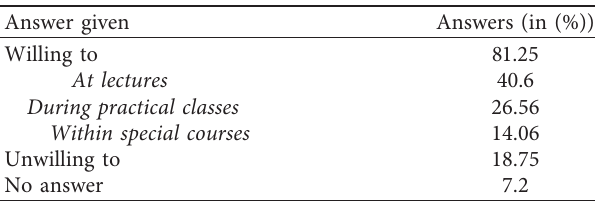
Table 1: Students’ willingness to obtain information on scientific and academic